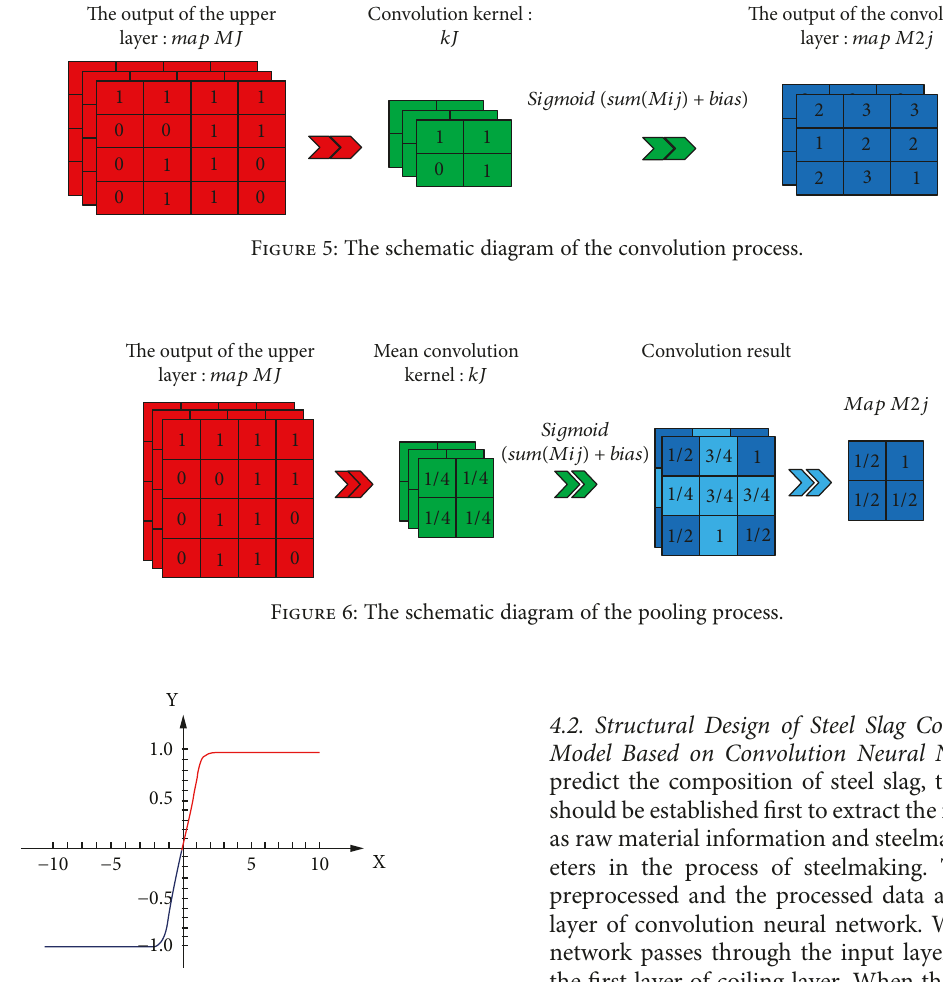
Figure 7: The image of the tanh